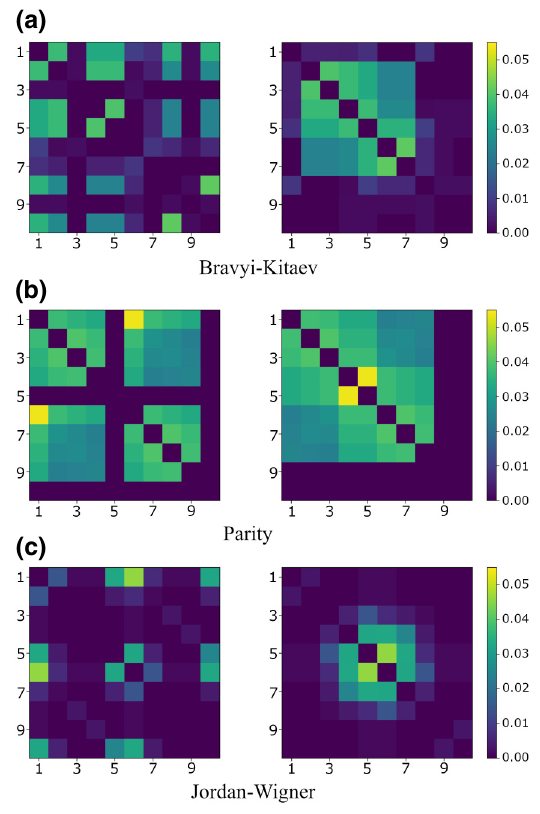
FIG. 4. Entanglement maps built from the exact wave func- tion for LiH in the STO-3G basis in a reduced active space of ten spin-orbitals for the three commonly used mappings (a)–(c). On the left, the default Hamiltonian is used, and on the right, the permuted Hamiltonian is used. The numbers on the axes indi- cate qubit indices. Different values of mutual information I ij are shown with different colors, with the color map shown on the